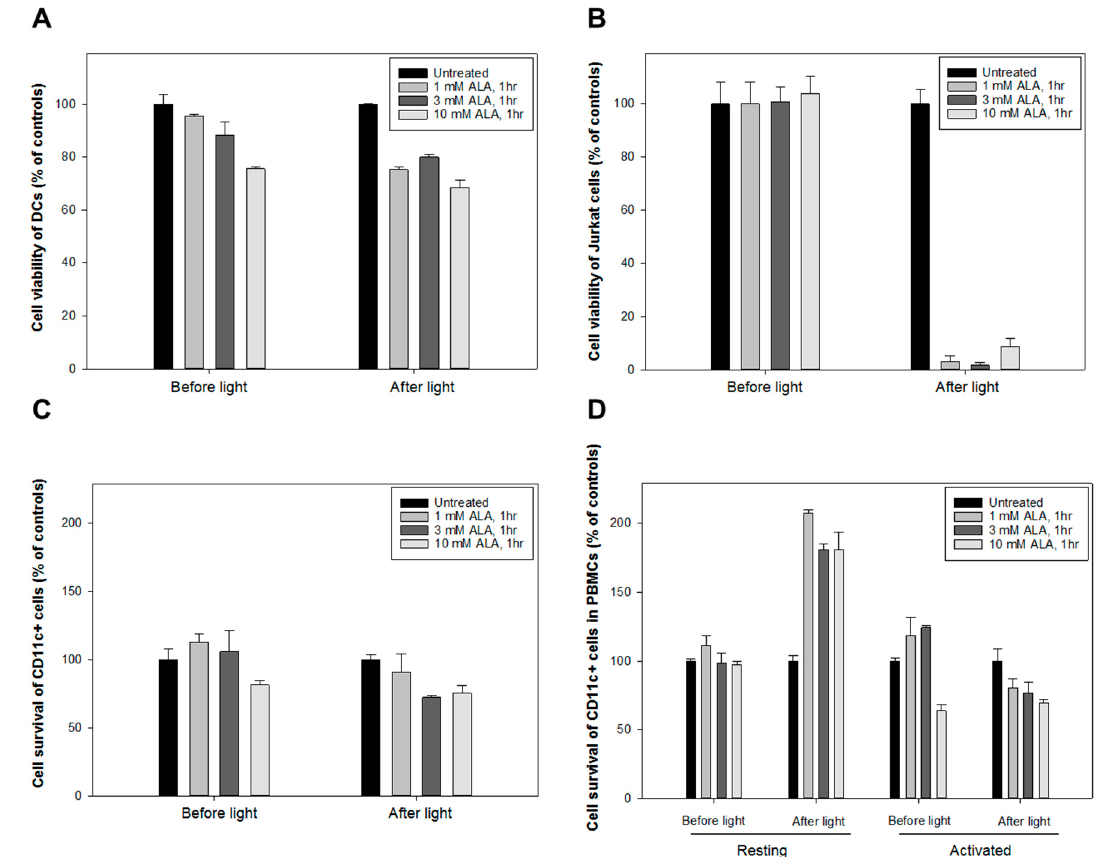
Figure 8. Monocyte-derived dendritic cells (DCs) resistant towards ALA-PDT. CellTiter Glo ® (CTG) luminescent cell viability assay was performed on DCs and Jurkat cells. Up to 3 × 10 5 DCs or Jurkat cells / well were seeded in the Corning ® 96-well white polystyrene microplates and incubated at 37 ◦ C for 24 h. The cells were then incubated with ALA at various concentrations for 1 h and irradiated with the LED blue light at 1.8 J / cm 2 . The cell survivals were measured at 24 h after light exposure. ( A ) for DCs, ( B ) for Jurkat cells, ( C ) for pure CD11c + DCs, and ( D ) for CD11c + DCs isolated from anti-CD3 / CD28 activated PBMCs.